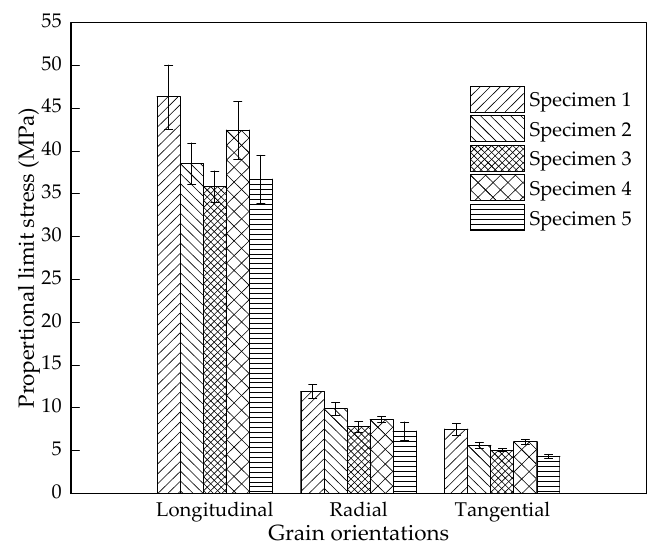
Figure 8. Proportional limit stresses of five types of specimens.